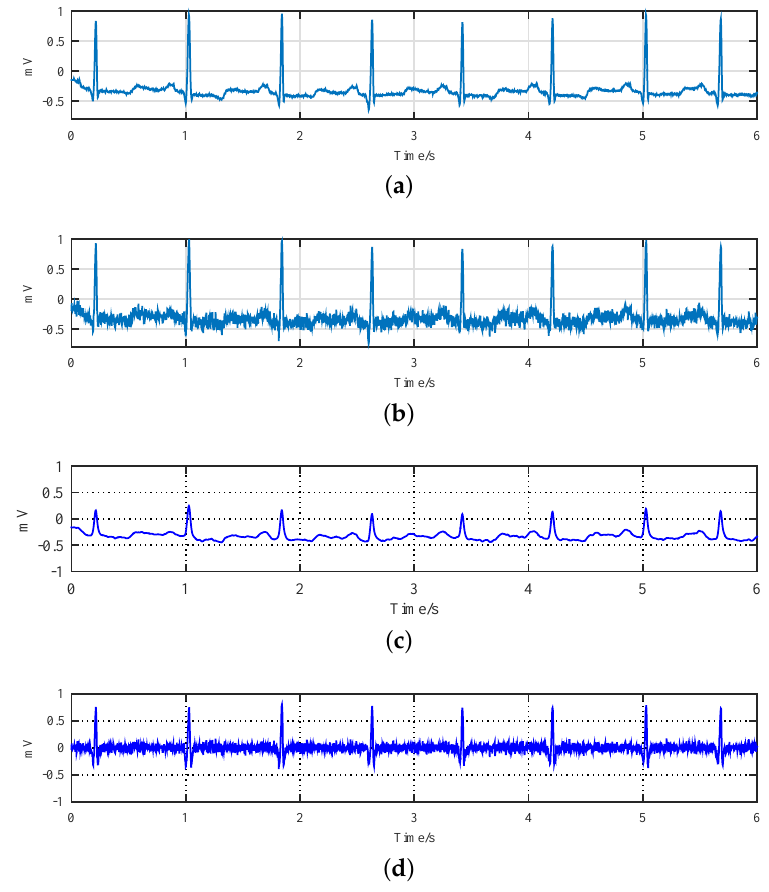
Figure 5. Comparison of the original ECG signal y , the noisy ECG signal s , the low-pass filtered signal ˜ l and the residual sparse component d w in the proposed sparse denoising framework. ( a ) No.100 MIT-BIH ECG; ( b ) Noisy ECG with 10 dB SNR; ( c ) Output of the LPF; ( d ) Residual noisy sparse